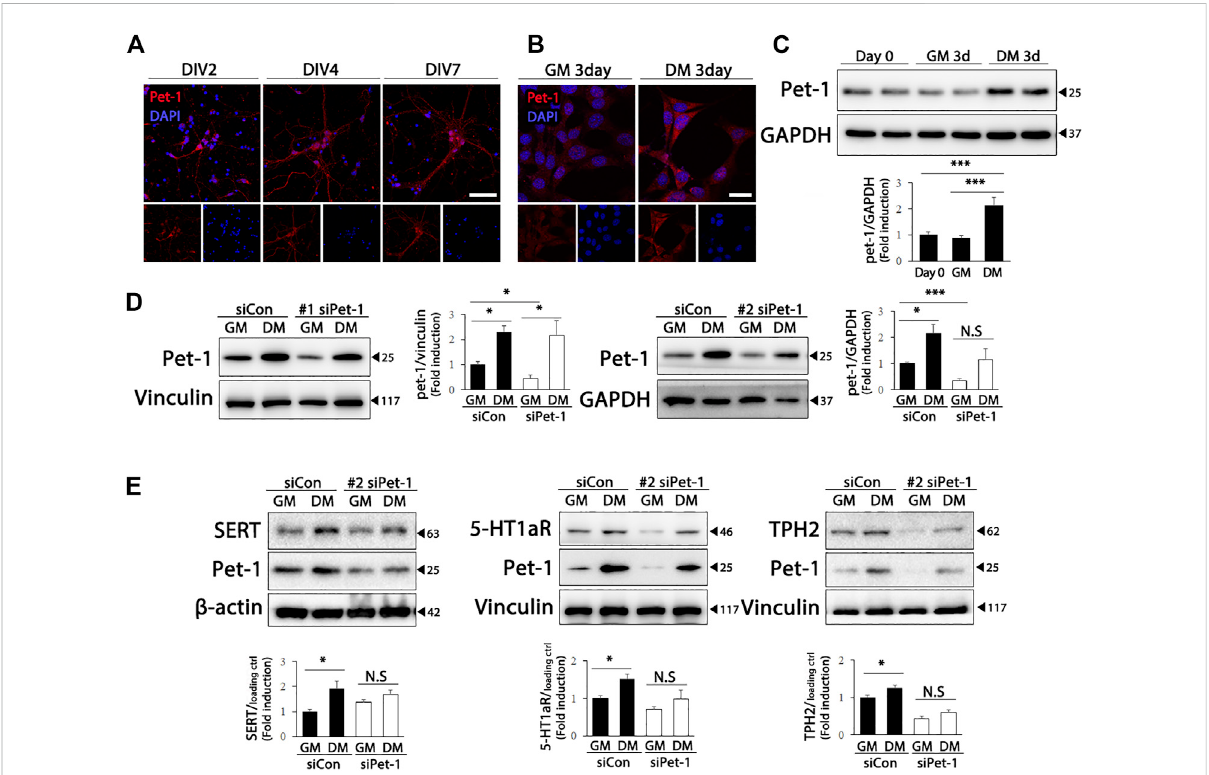
FIGURE 3 Pet-1 enhances the serotonergic phenotype in differentiated HT22 cells. (A) Immuno fl uorescence staining of Pet-1 (red) in hippocampal primaryculture.DAPIstaining(blue)indicatesthenucleus.Scalebar=50 μ m. (B,C) Pet-1(red)immuno fl uorescencestaining (B) andwesternblotting (C) of HT22 cells grown in normal growth medium and differentiation medium for 3 d. DAPI staining (blue) indicates the nucleus. Scale bar = 25 μ m. GAPDHisusedasloadingcontrol. (D,E) ControlsiRNAandPet-1 siRNAweretransientlytransfectedinHT22 cells,changedwithnormal growth medium and differentiation medium for 3 d. Western blotting for analyzing Pet-1 (D) and SERT, 5-HT 1a R, and TPH2 (E) expression. GAPDH, vinculin, and β -actin were used as loading controls. Data are representative of at least three independent experiments and are quanti fi ed using